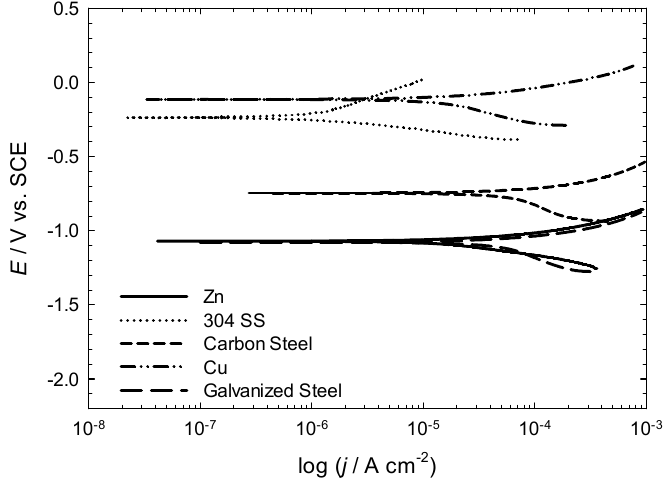
Figure 6. Tafel plots measured for various metal specimens during their immersion in thermal water taken from source AM34. Scan rate: 2 mV·s − 1 . Measurements were performed in the naturally aerated water at ambient